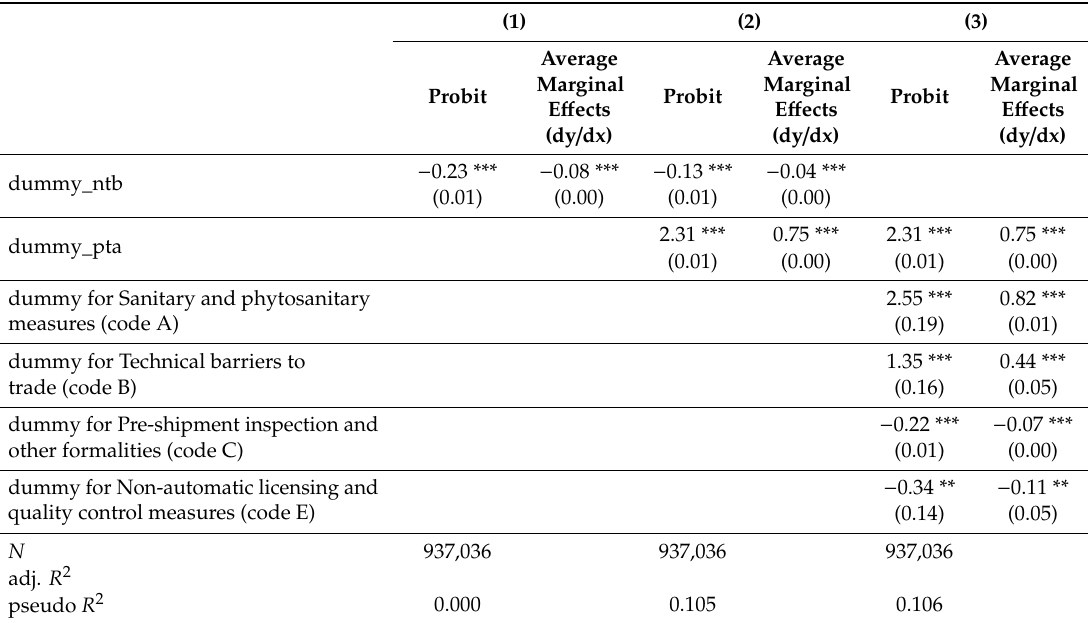
Table 3. Impact on the extensive margin of